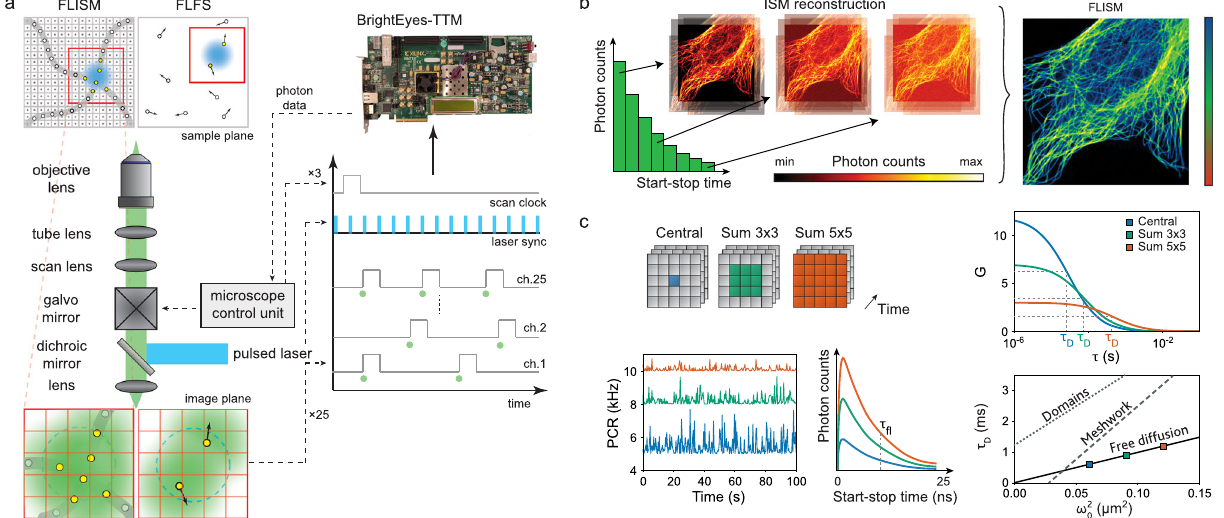
Fig.1|ConceptsofFLISMandFLFS.a InFLISM,apulsedlaserbeamisfocusedand scannedacrossthesample.Foreachpositionofthelaserbeam,the fl uorescenceis collected and focused onto a SPAD array detector. Every photon produces a pulse in one of the detection channels almost instantaneously. The BrightEyes-TTM measuresthe arrivaltime of the photonwith respectto the last laserpulse and the pixel, line, and frame clock of the microscope. In single-point spot-variation FLFS, the laser beam is kept steady while the photon arrival times are measured. The movement of the fl uorophores results in temporal fl uctuations in the intensity trace. b A super-resolution fl uorescence lifetime (FLISM) image can be recon- structed from the resulting 4D dataset ( x , y , t , ch). For each time bin of the TCSPC